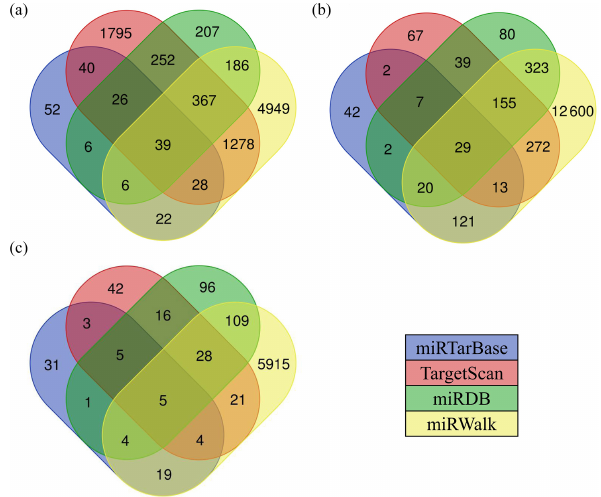
Figure 5. Various types of software for predicting the target genes of miRNAs. The numbers in the intersection of the four circles refer to the candidate target genes of